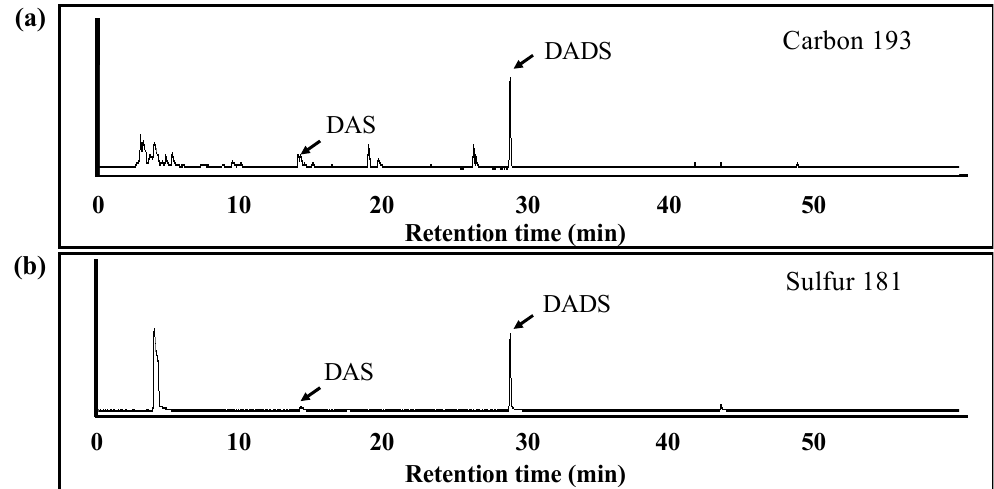
Figure 8. Element chromatograms of volatile compounds obtained from the mixture of ACSO and proteins of the small intestine to assess ACSO metabolism. Carbon was detected at 193 nm ( a ) and sulfur was detected at 181 nm ( b ).